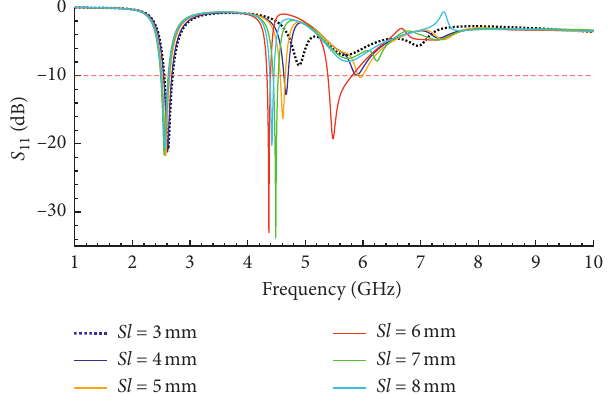
Figure 23: S 11 changes due to BioAs-MPA.